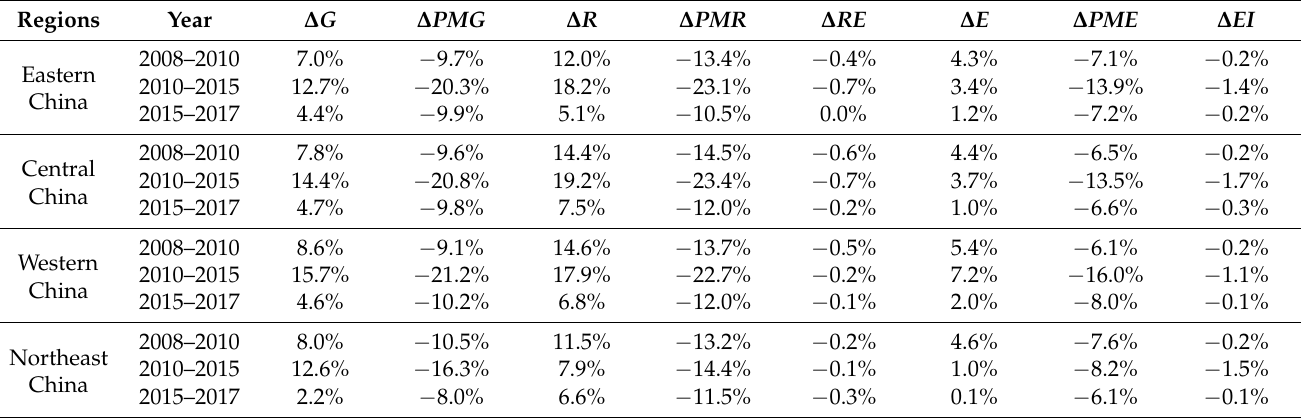
Table A3. Decomposition results of China’s four subregions over different periods (unit: